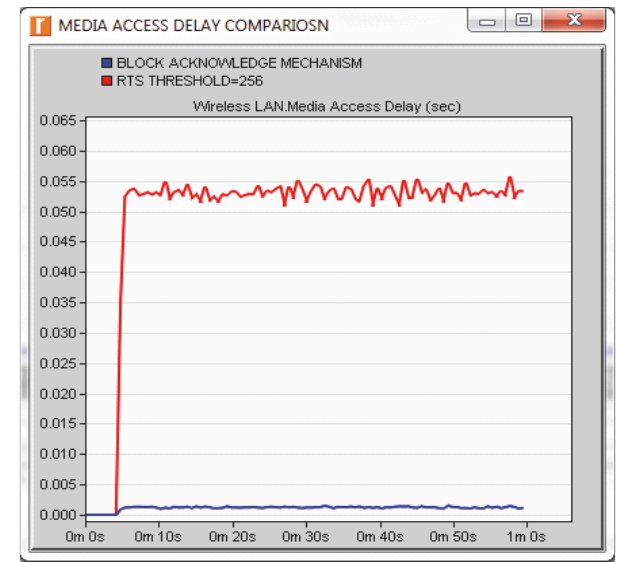
Figure8:WLANmediaaccessdelaycomparisonforblockacknowl- edgement versus RTS mechanism.